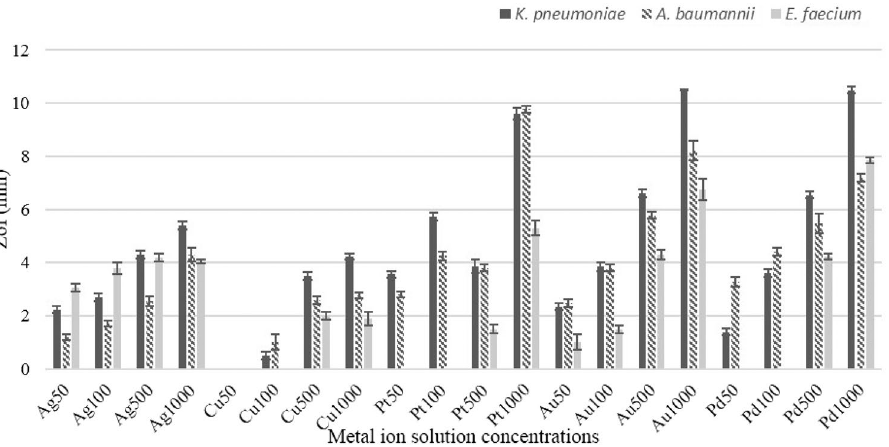
Figure 1. Zone of inhibition values for five metals at different concentrations against tested three pathogens demonstrating that at higher concentrations platinum, gold and palladium were the most effective antimicrobials whereas at lower concentrations silver demonstrated the greatest antimicrobial activity ( p < 0.001). Au = gold, Cu = copper, Pt = platinum, Pd = palladium and Ag = silver. 50, 100, 500 and 1000 are at concentrations in mgL − 1 (n =